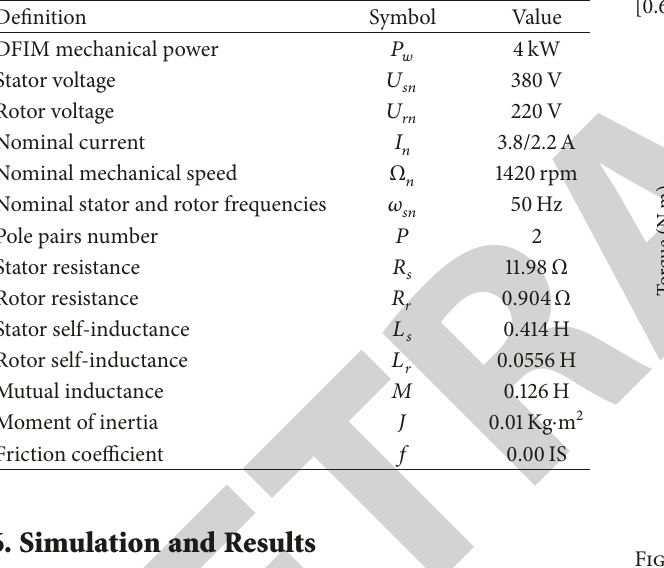
Table 2: Parameters of the DFIM [12]. Figure 7: Result of speed under a load Cr = 5 N ⋅ m in the interval [0.6 Sec–1.6 Sec].